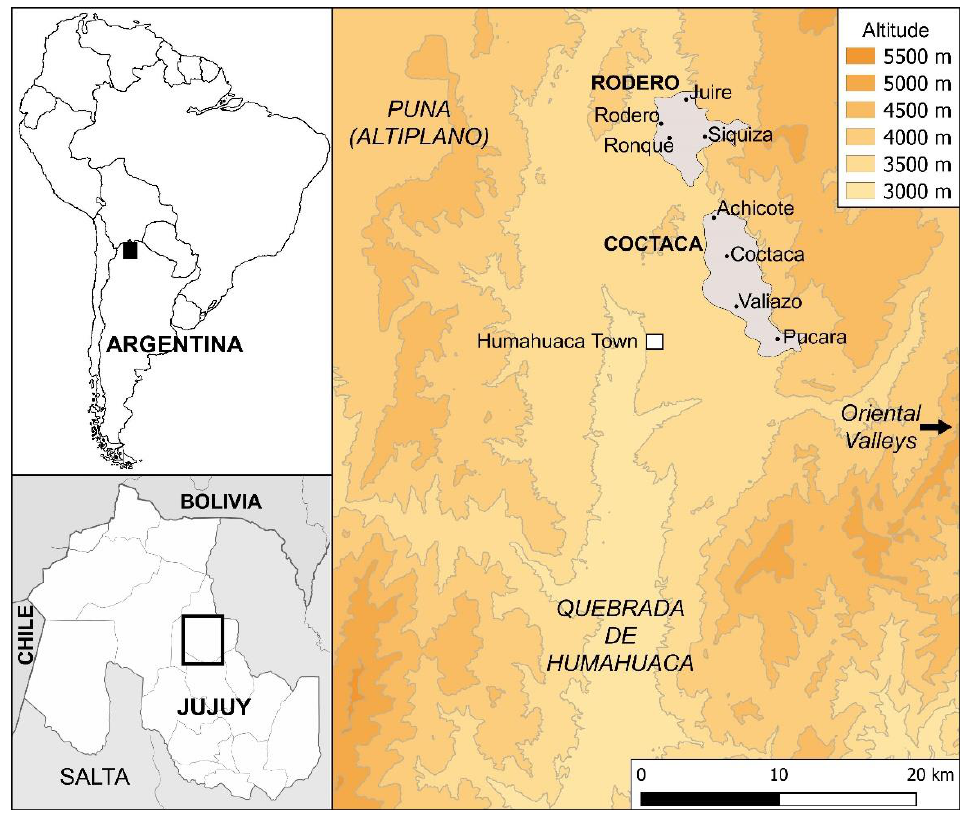
Figure 1. Location of Coctaca and Rodero areas, Province of Jujuy, Argentina.